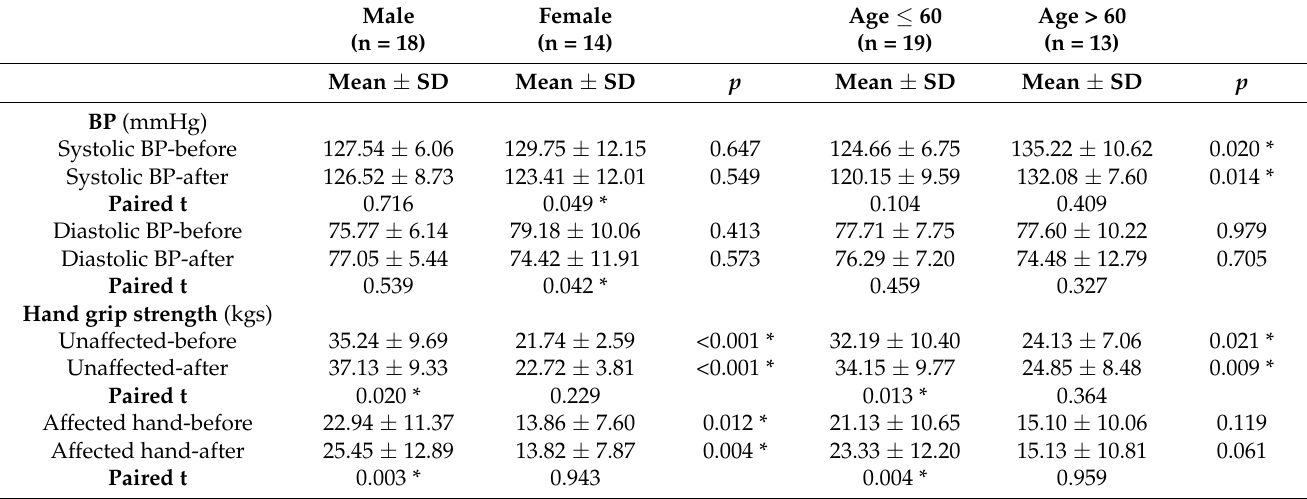
Figure 2. The pre- and post-intervention levels of SBP, DBP, and hand grip strength of the unaffected and affected hands between the yoga and control groups (paired t -test is shown with a solid line and independent t -test with a dotted line) *: p < 0.05. (Bars represent the standard deviation). Table 2. The BP and hand grip strength of subgroups before and after intervention among sub- groups.